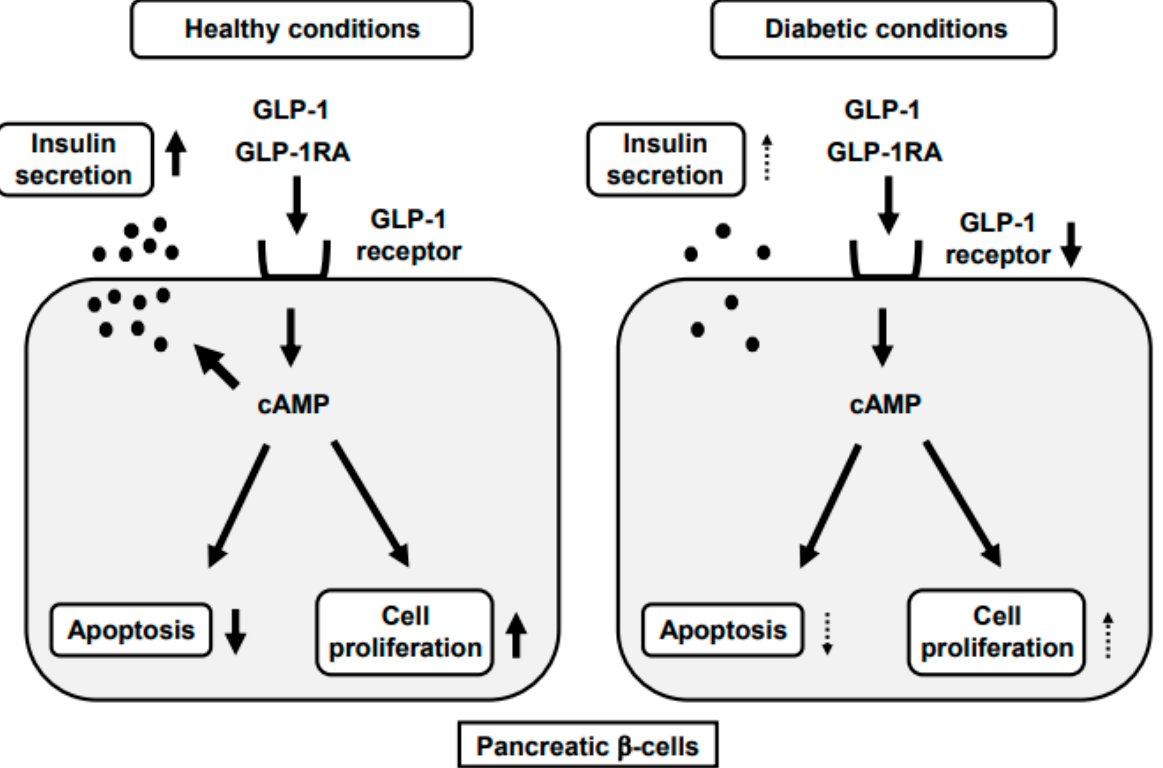
Figure 1. Reduction of GLP-1RA effects on pancreatic β -cells under diabetic conditions. GLP-1 binds to its receptor in pancreatic β -cells, which leads to the enhancement of insulin secretion, reduction of apoptotic cell death and increase of β -cell proliferation. After chronic exposure to hyperglycemia, however, GLP-1 receptor expression in β -cells is reduced, which weakens the protective effects of GLP-1 and GLP-1RA against β -cells glucose toxicity.